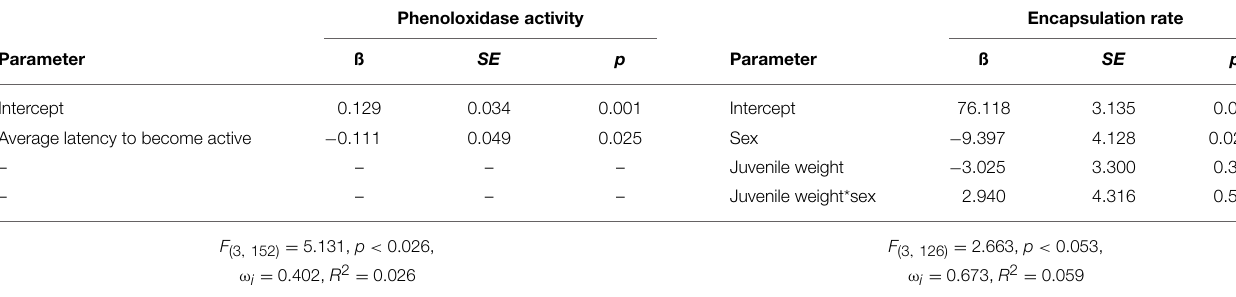
TABLE 7 | Top generalized linear models predicting phenoloxidase activity and encapsulation